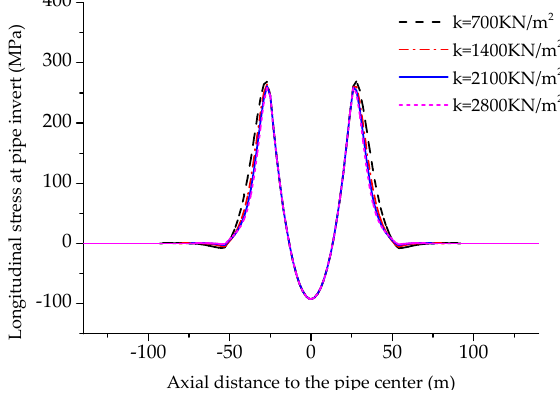
Figure 19. Longitudinal stresses at pipe invert for pipes with various wall thicknesses.